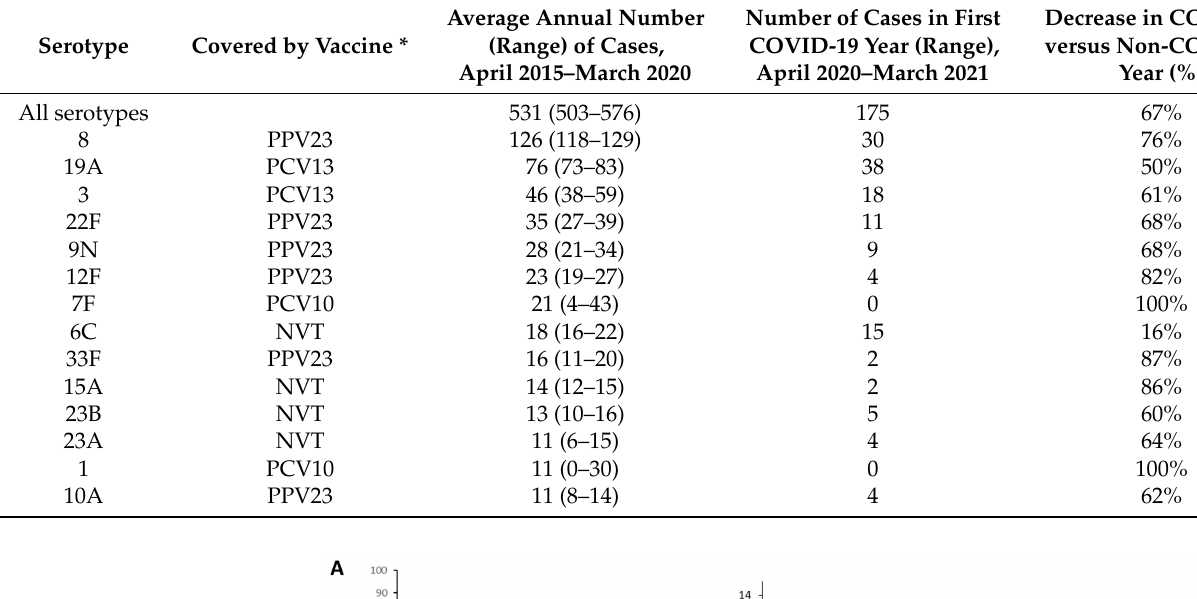
Table 1. Number of cases of invasive pneumococcal disease per serotype as average and range of pre-COVID-19 period (2015–2020) and first COVID-19 year in all age groups except those aged 73–79 years old. Decrease in number of serotype-specific IPD cases is indicated by percentage. * If covered by PCV10, then PCV10 is used, if not in PCV10 but in PCV13, then PCV13 is used, if not in PCV13 and PCV10 but in PPV23, then PCV23 is used. If not covered by any of the currently available vaccines, non-vaccine type (NVT) is used.